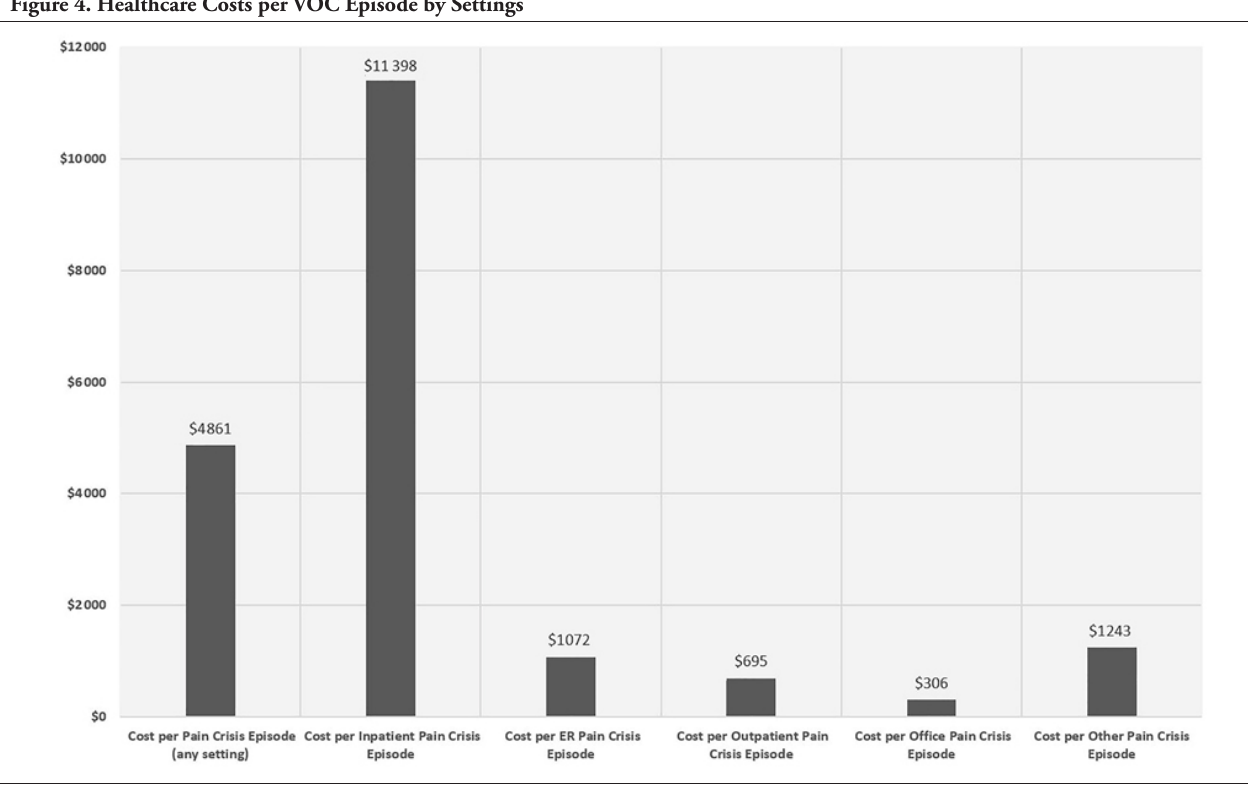
Figure 4. Healthcare Costs per VOC Episode by Settings